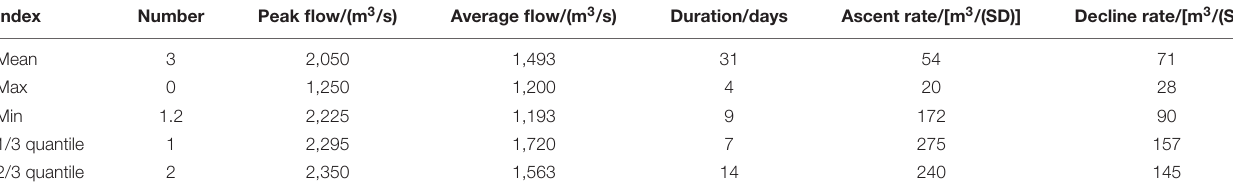
TABLE 4 | Characteristic values of the high flow pulse of Lanzhou during flood period before 1957.